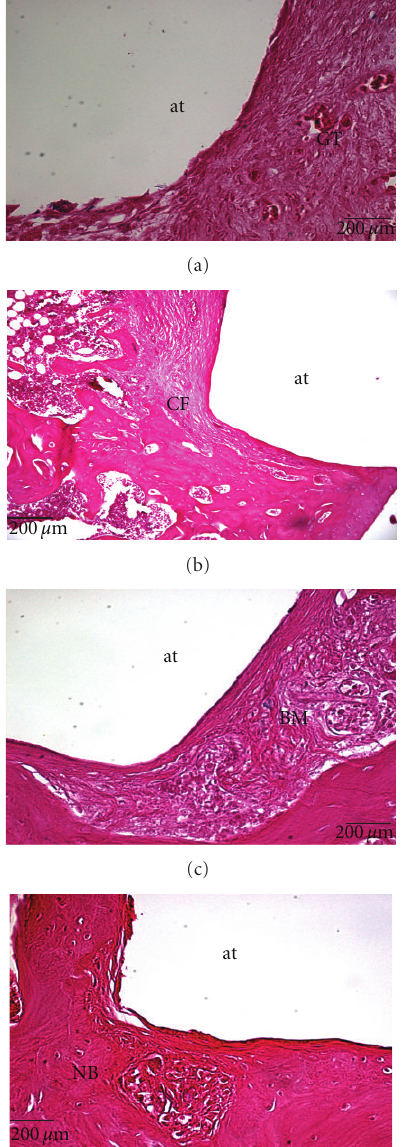
Figure 10: Mean EGs collagen fibers. Absence: 9%, moderate: 69%, and intensive: